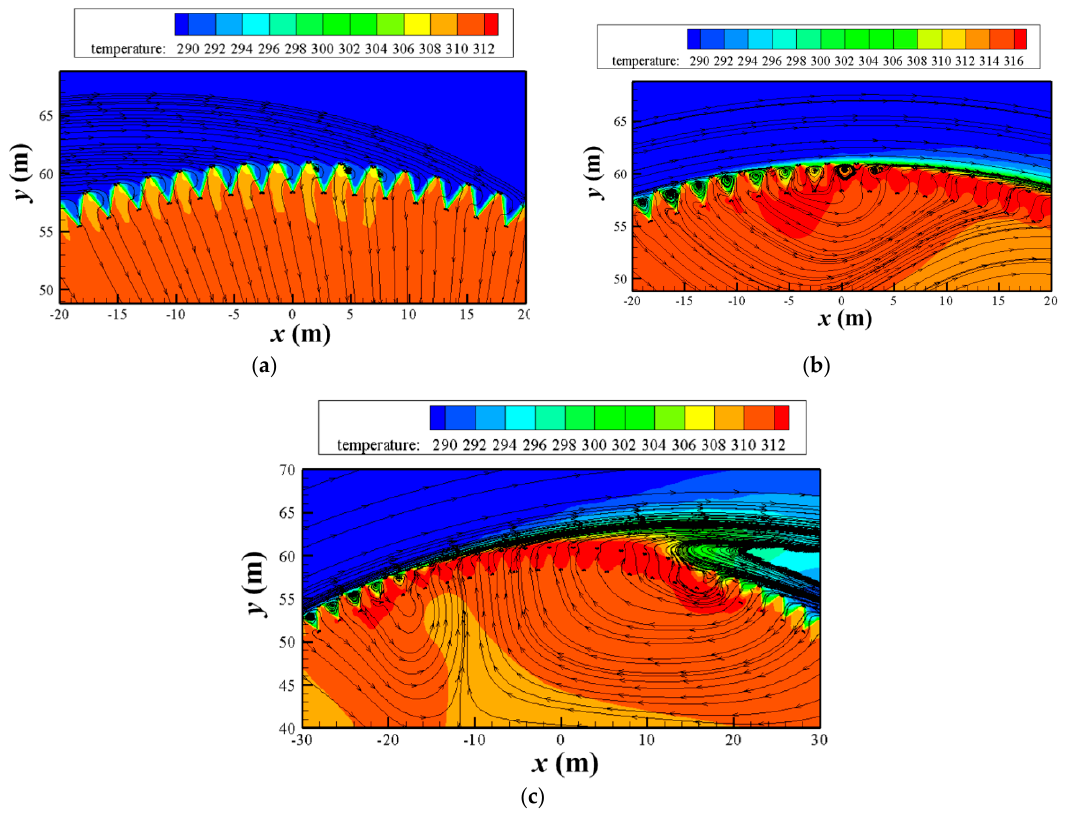
Figure 9. Flow and temperature fields through lateral cooling deltas for case A at various wind speeds. ( a ) at 4 m/s; ( b ) at 12 m/s; ( c ) at 20 m/s.